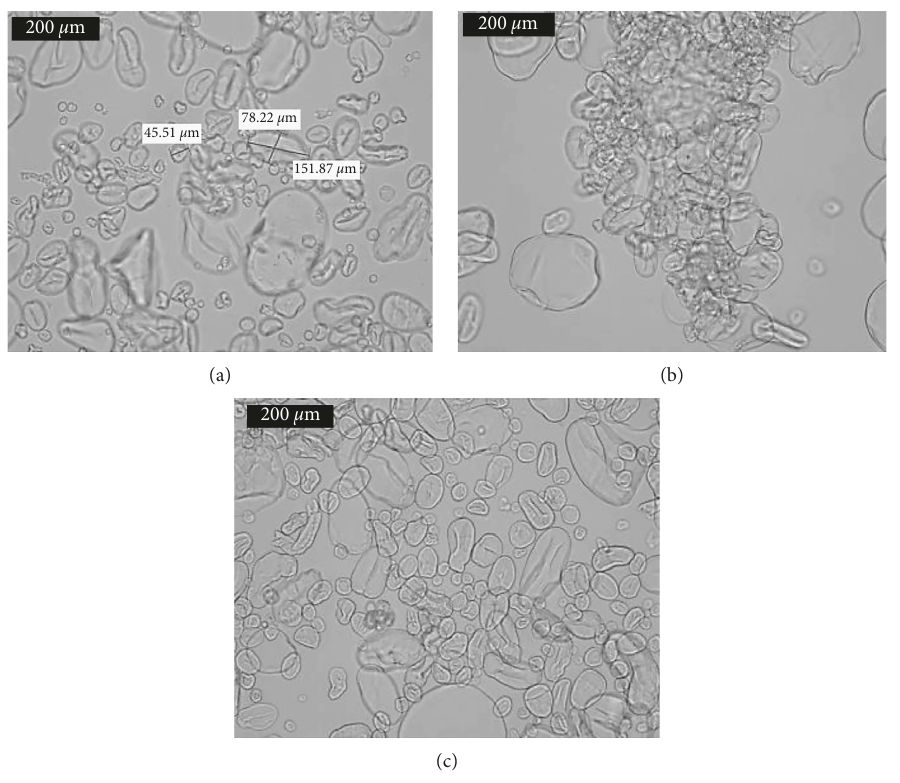
Figure 5: Comparison of hydrogel beads made from CMS 3.2% by (a) ionotropic gelation with CaCl with CS 0.01% w/v, and (c) combination of ionotropic gelation and polyelectrolyte complexation (CaCl 2 1% w/w). Scale 100x.